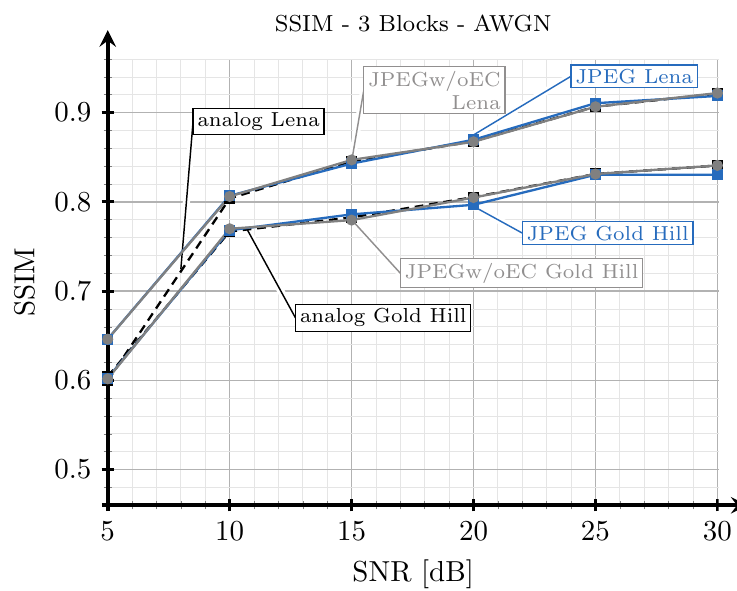
Figure 16. SSIM vs. SNR for three blocks and AWGN